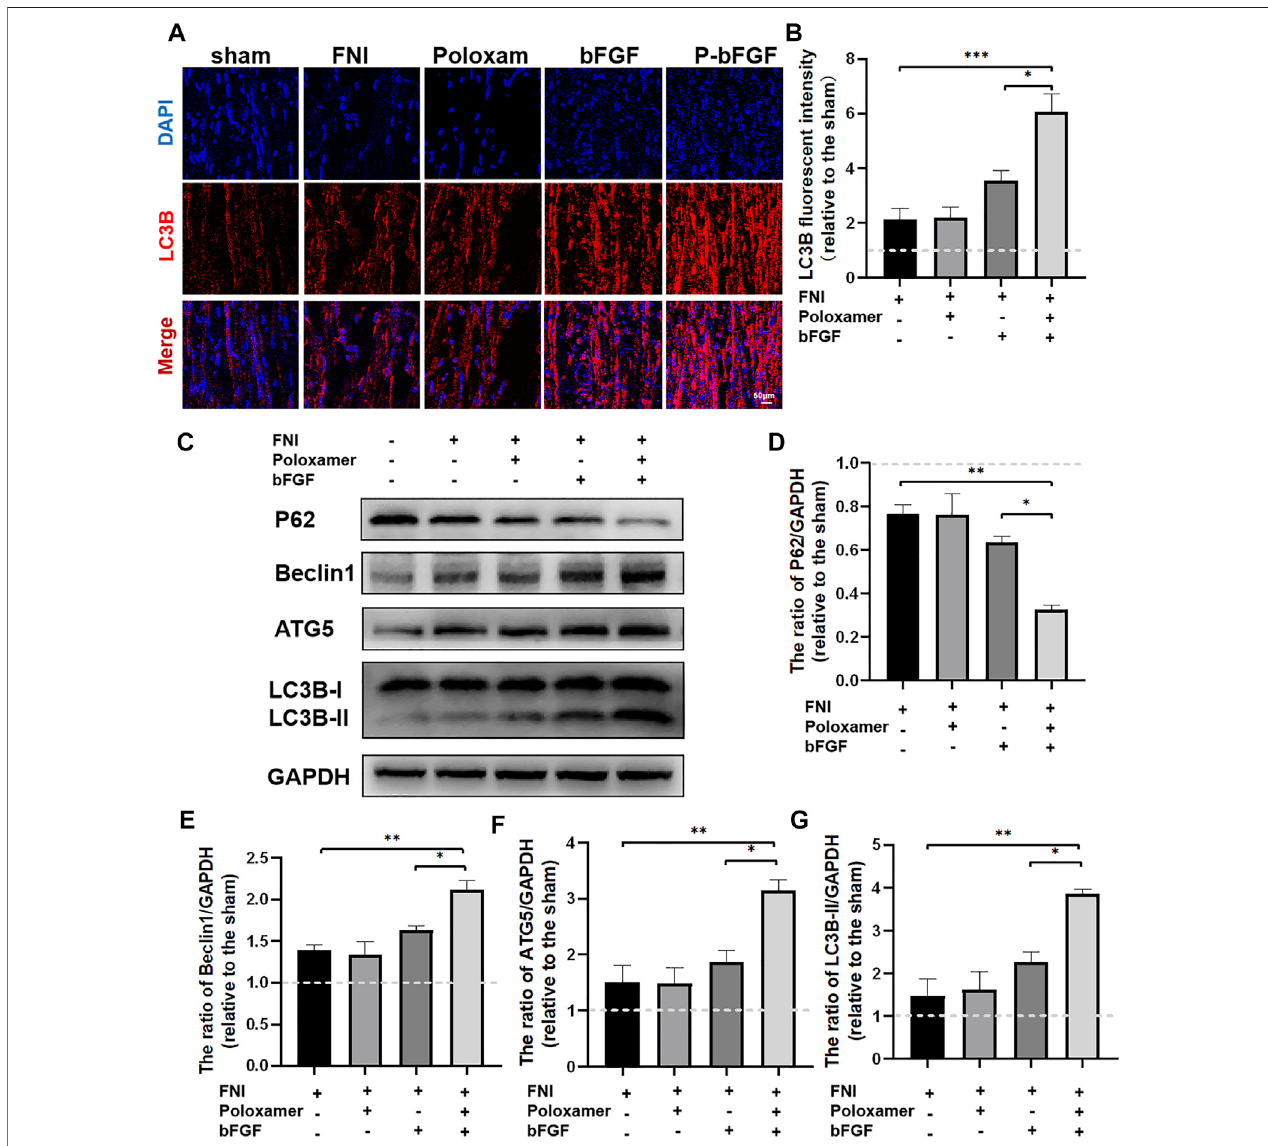
FIGURE 3 | P-bFGF activated autophagy in order to promote facial nerve repair. (A) Representative immuno fl uorescence staining of LC3B of injured nerves 2 weeks after treatment; scale bar = 50 μ m. (B) Quantitative calculation ofthe mean of LC3B fl uorescence. The data were expressed as mean ± SEM ( n = 4); FNI group vs. P-bFGFgroup:*** p < 0.001,bFGFgroupvs.P-bFGFgroup:* p < 0.05. (C – G) RepresentativewesternblotimagesofP62,Beclin1, ATG5,andLC3B-IIexpression in FNI 7 days after treatment and quanti fi cation of protein levels. The data were expressed as mean ± SEM ( n = 3); FNI group vs. P-bFGF group: ** p < 0.01, bFGF group vs. P-bFGF group: * p < 0.05. A dashed line at 1.0 represented sham